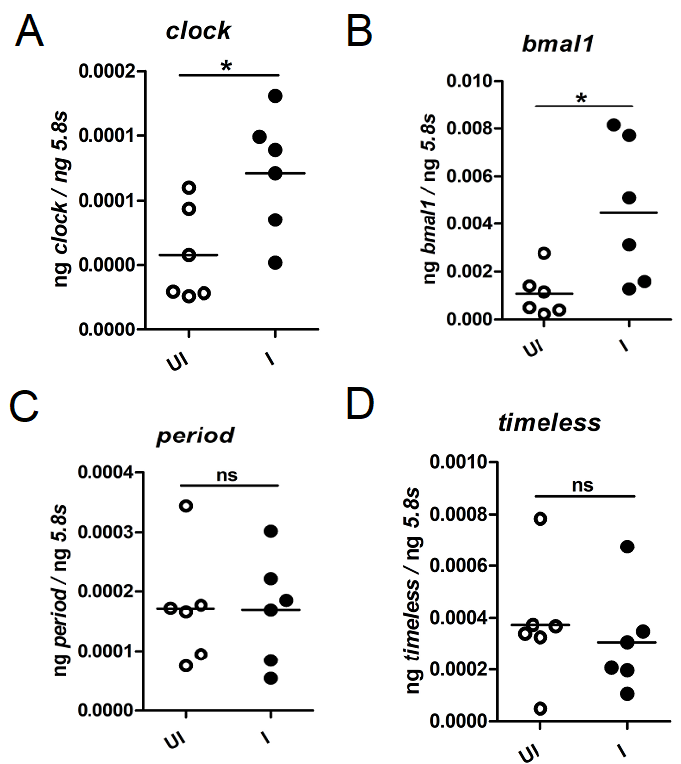
Figure 4. Expression of tick clock and bmal1 are upregulated during transmission of A. phagocytophilum from ticks to the murine host. QRT-PCR results showing levels of circadian gene transcripts; clock ( A ); bmal1 ( B ); period ( C ); timeless ( D ) in uninfected (open circles) or A. phagocytophilum -infected (closed circles) nymphs fed on naïve mice. Levels of tick circadian gene transcripts were normalized to tick beta-actin levels. Both uninfected and A. phagocytophilum -infected fed ticks were generated from the same batch for consistency. Statistical analysis was performed using Student’s t -test comparing uninfected (UI) and A. phagocytophilum infected (I) ticks in each group. Each circle represents data from one tick sample. A p -value of less than 0.05 was considered significant. * p < 0.05, ns—not significant.